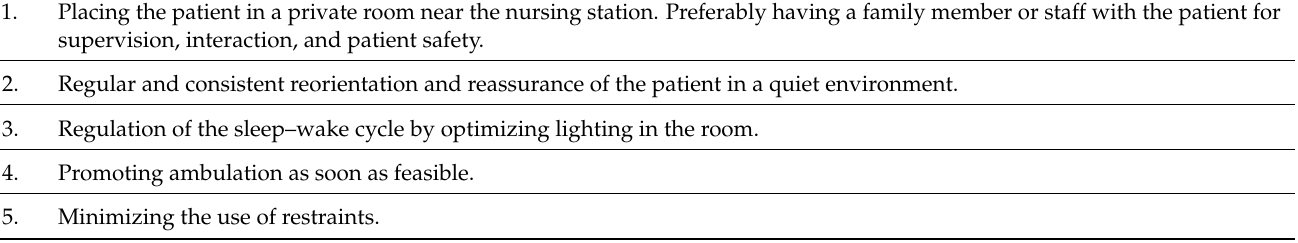
Table 5. Non-pharmacological interventions to prevent